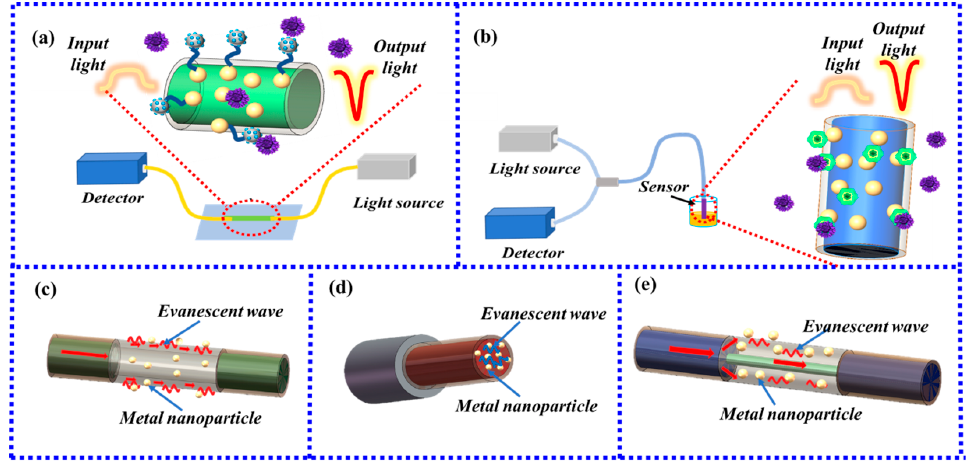
Figure 2. ( a ) Transmissive structure; ( b ) Reflective structure; ( c ) Hollow core fiber LSPR sensor; ( d ) Fiber end face LSPR sensor; ( e ) Fiber core mismatch LSPR sensor.